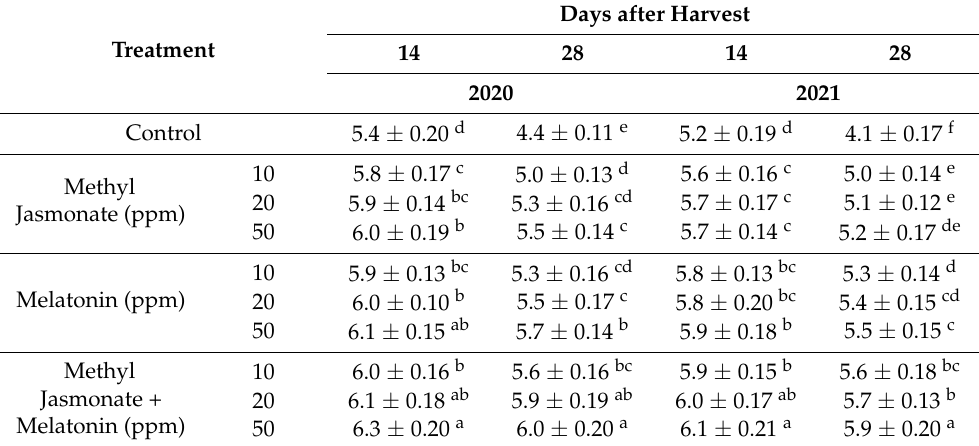
Table 4. Effects of foliar application of melatonin and/or methyl jasmonate solutions at different concentrations on the firmness (g cm − 2 ) in date palm fruits (cv. Barhi) stored at 4 ◦ C for 28 days